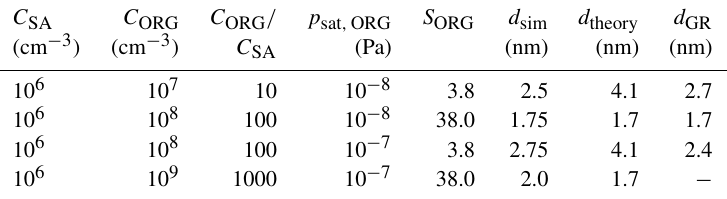
Table 4. The activation size ( d sim ) determined from four simulations, the corresponding critical size from nano-Köhler theory ( d theory ) and the size at which GR starts to increase with size in each simulation ( d GR ). The activation size is here defined as the size when 50% of the cluster flux is due to organic vapor monomer. The concentrations of sulfuric acid ( C SA ) and organic vapor ( C ORG ), their ratio, organic saturation vapor pressure ( p sat , ORG ) and organic saturation ratio (S ORG ) are shown for each case. C SA C ORG C ORG / p sat , ORG S ORG d sim d